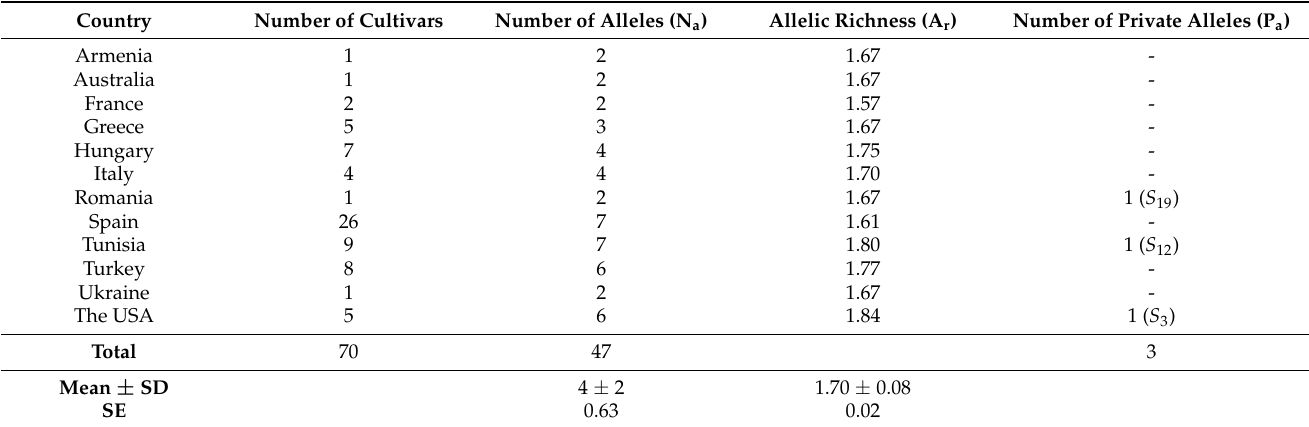
Table 3. Genetic parameters of apricot traditional cultivars including landraces and local selections. Number of cultivars, number of alleles (N a ), allelic richness (A r ), and number of private alleles (P a ) for each country of origin. SD: standard deviation; SE: standard